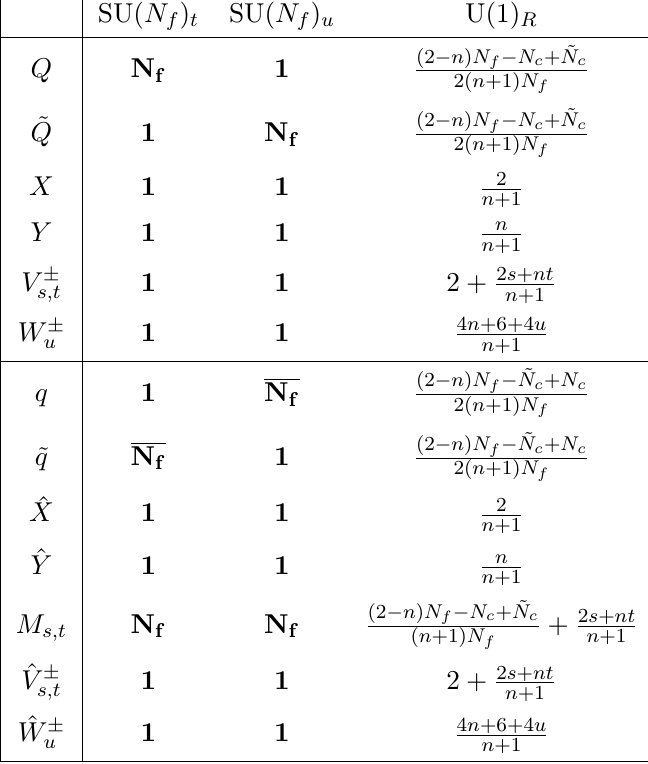
Table 5 . The representations of the chiral operators under the global symmetry groups of the double adjoint theory with the linear monopole superpotential ∆ W = V + + V − and its dual. A 0 , 0 0 , 0 ˆ Now the monopole operators ( V ± ) and ( ˆ V ± ) are presented together with the elementary , W ± , W ± s,t s,t u u fields in the upper box and the lower box respectively. Note that ˜ N is the dual gauge rank, which c is defined by ˜ N = 3 nN 4 n − 2 c f − N c −